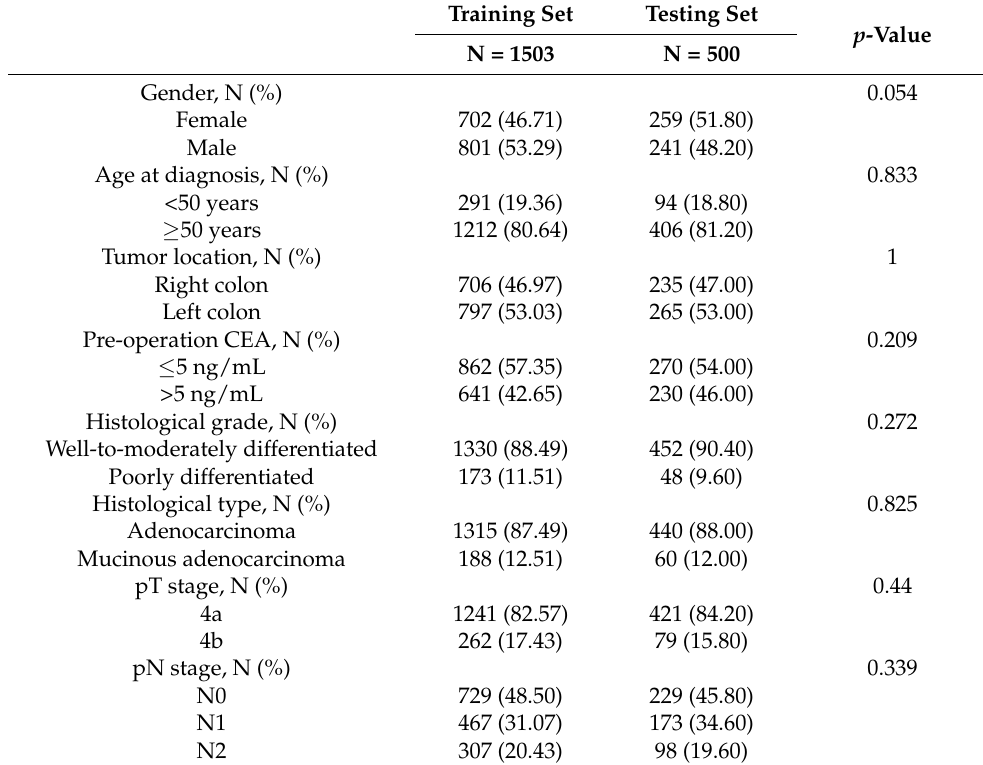
Table 2. Clinicopathologic features of patients in training and testing